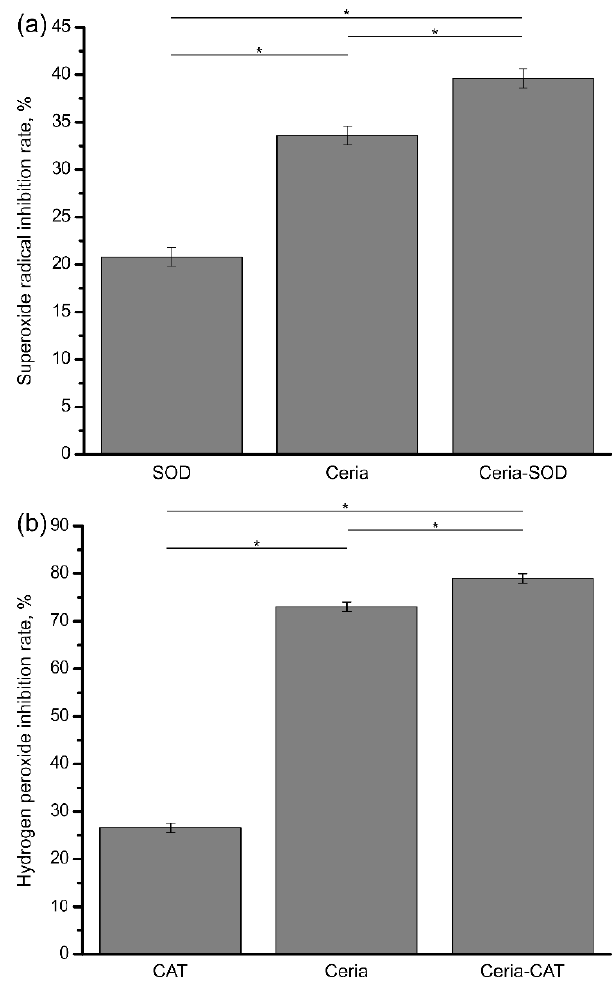
Figure 2. The results of the SOD enzymatic assay ( a ) and Amplex ® Red assay ( b ) performed for SOD-ceria and CAT-ceria conjugates, non-functionalized ceria, catalase and superoxide dismutase. Based on the obtained calibration curves, the percentage of superoxide radicals ( a ) and hydrogen peroxide ( b ) inhibition results were calculated and are presented herein. Asterisks represent significant difference between values ( p < 0.05, n = 4).